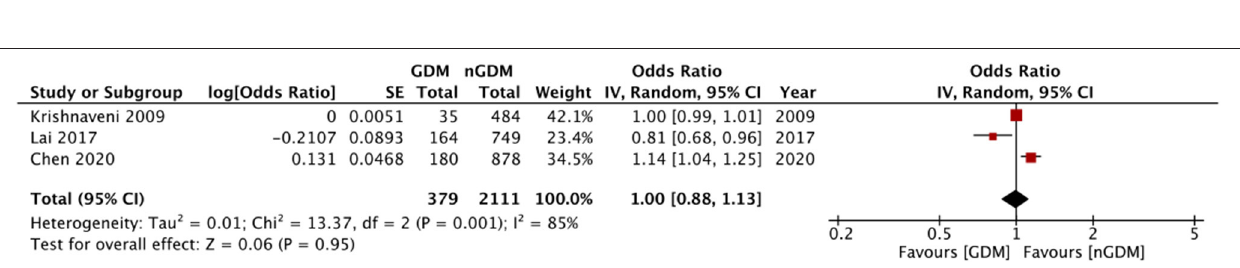
FIGURE 6 | Meta-analysis of adjusted odds ratios assessing relationship between GDM and vitamin B12 (as continuous